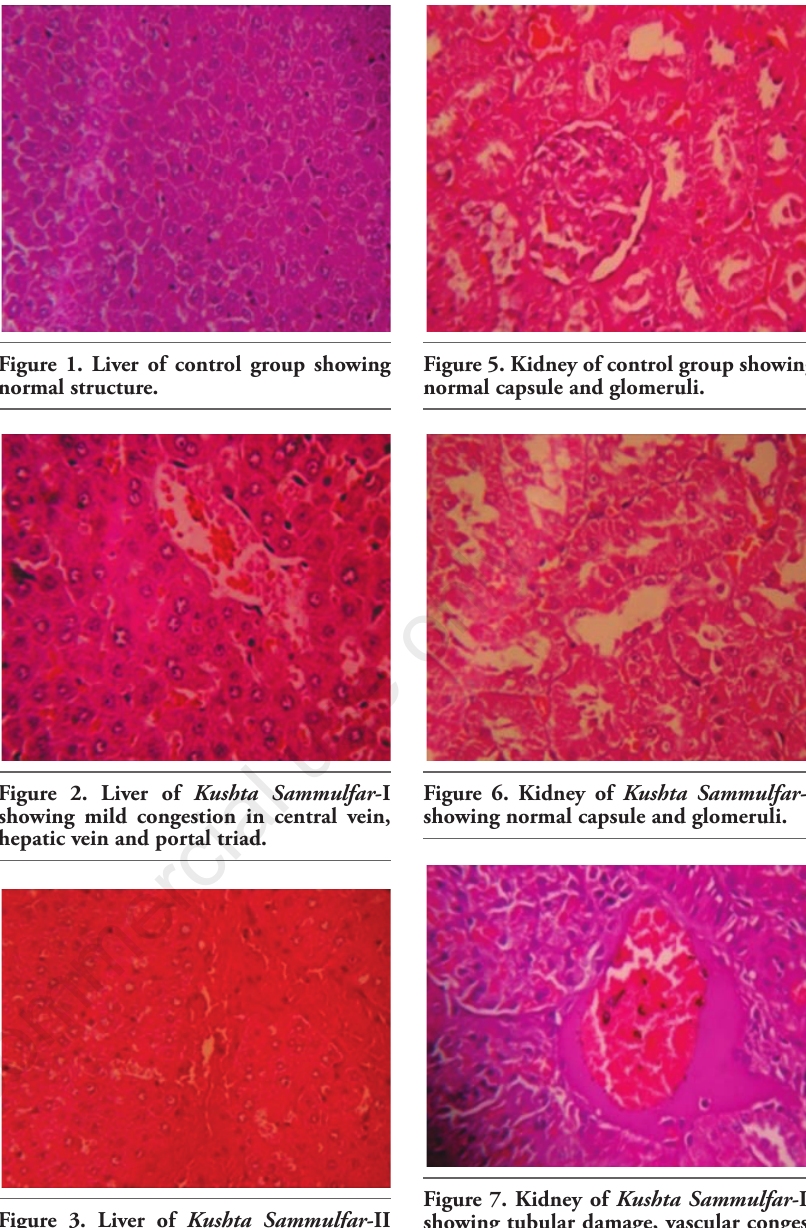
Figure 3. Liver of Kushta Sammulfar -II showing moderate congestion in central vein, hepatic vein and portal triad.